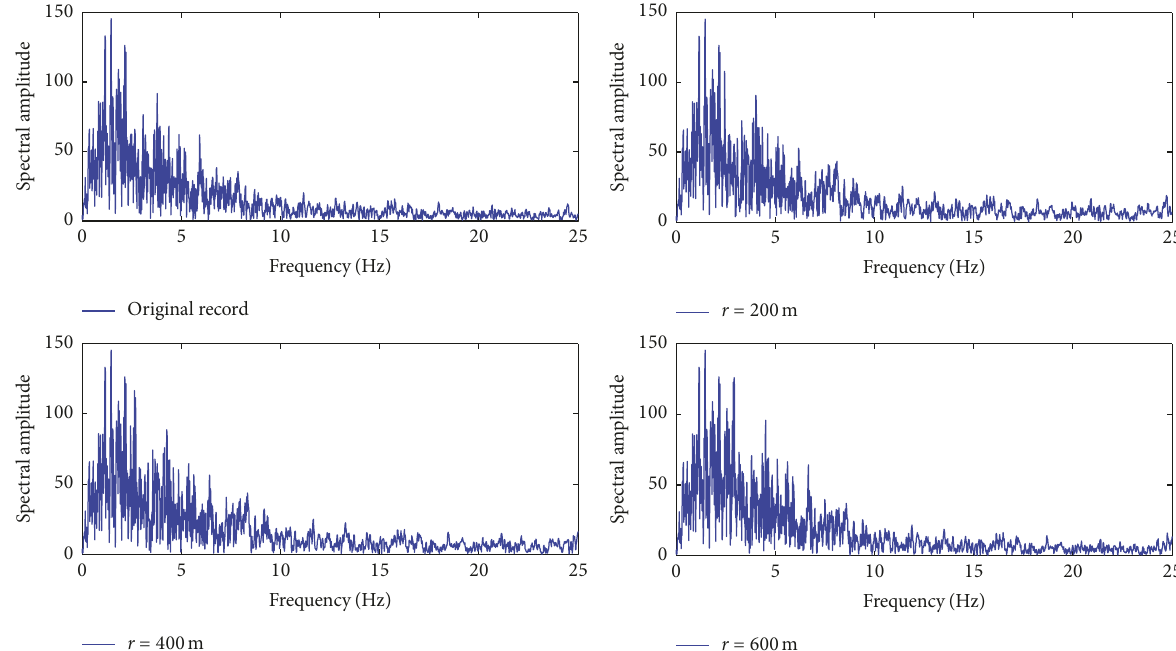
Figure 5: Comparison of Fourier amplitude of simulated motions to that of the original record.